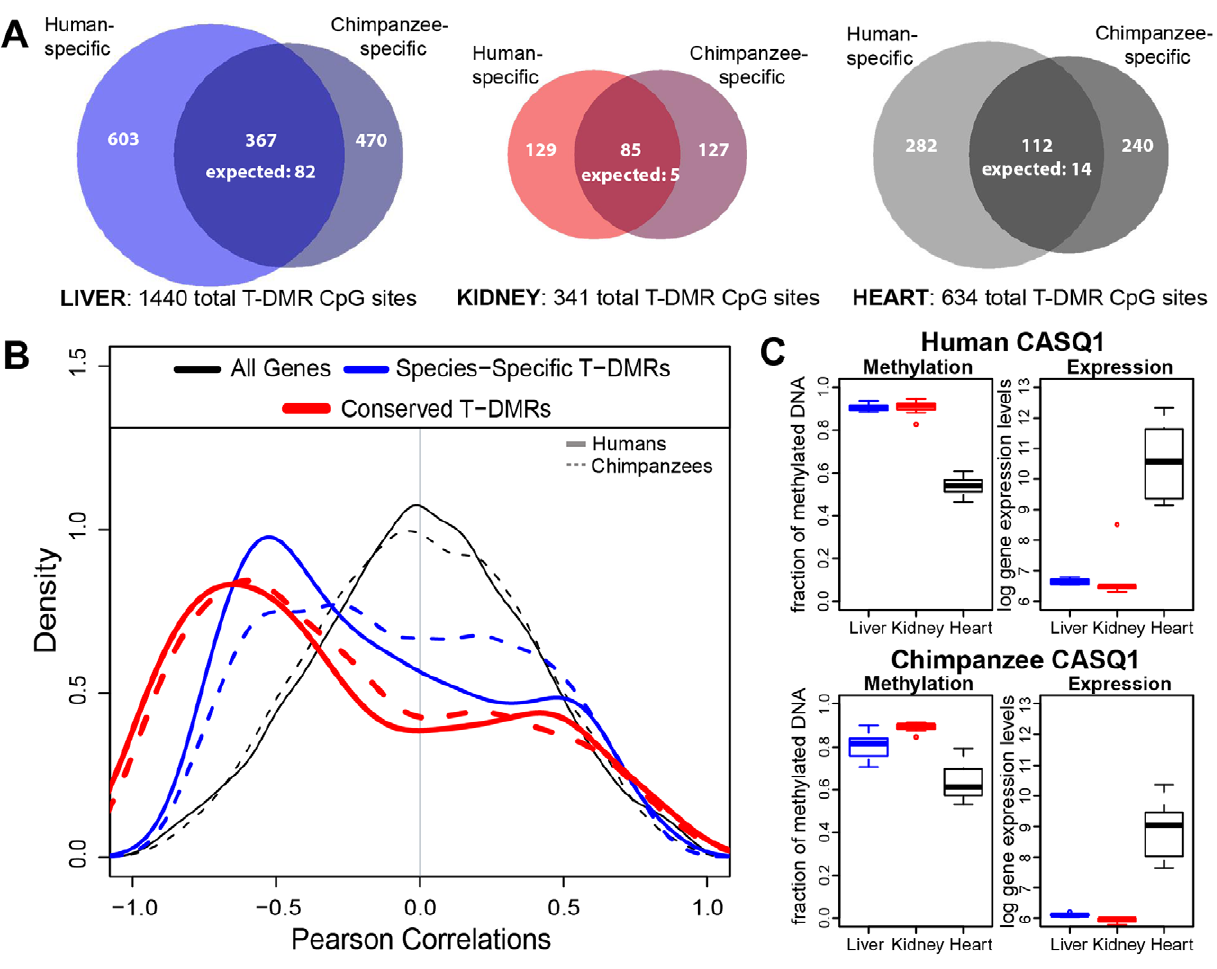
Figure 3. Conservation of tissue-specific differentially methylated regions. (A) Venn diagrams of the number of T-DMRs classified in each species per tissue. (B) Probability density functions (y-axis) of distributions of Pearson correlations (x-axis) between methylation and gene expression levels across tissues, in human (solid lines) and chimpanzee (broken lines), for all genes expressed in at least one tissue (black), genes associated with a T-DMR in only one species (blue), and genes associated with a conserved T-DMRs (red). See Figure S4 for plots of the tissue-specific data (C) A representative example of a heart-specific T-DMR associated with the CASQ1 gene. Plotted in the left panels are the methylation b -values (y-axis), and in the right panels are the normalized gene expression levels (y-axis) in liver, kidney, and heart samples from human (top) and chimpanzee (bottom).